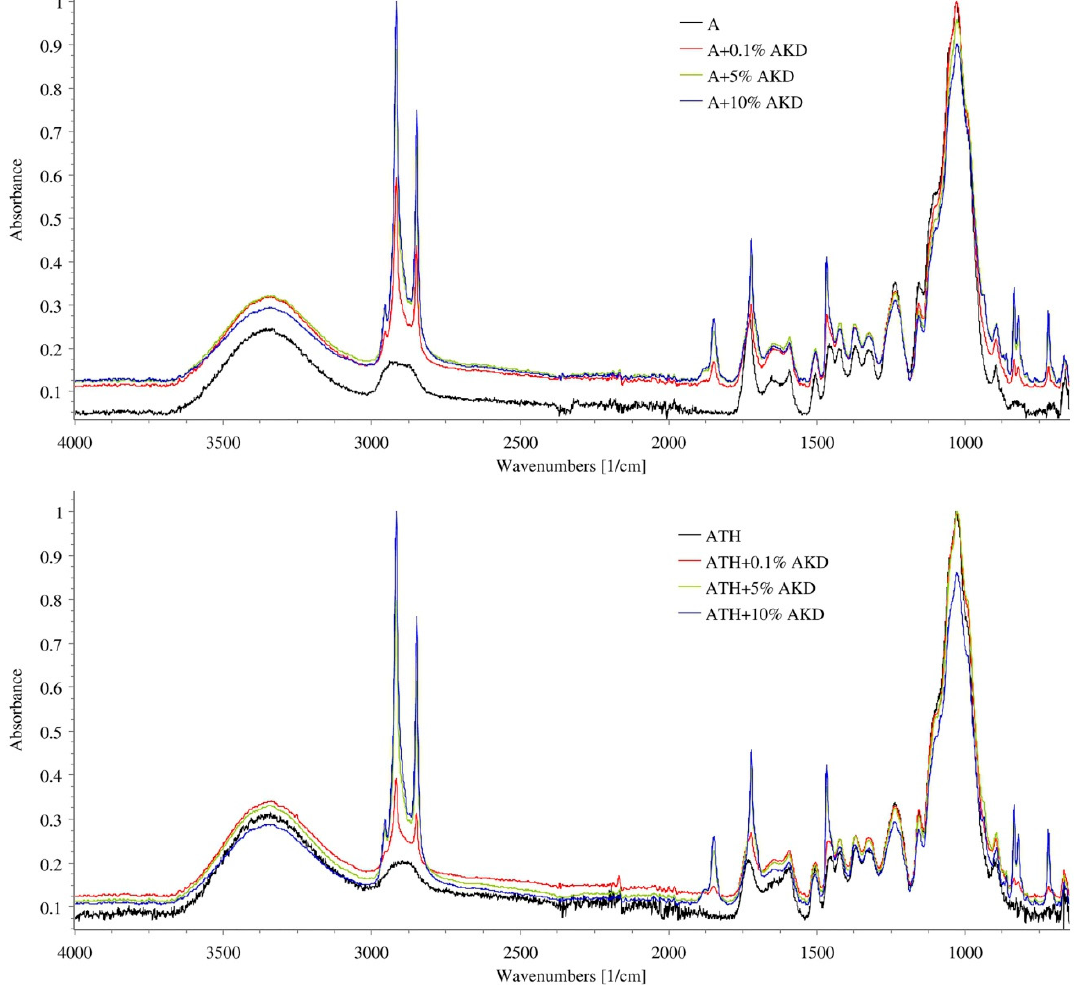
Figure 6. Comparison of FTIR spectra of A ( top ) and ATH ( bottom ) with AKD.